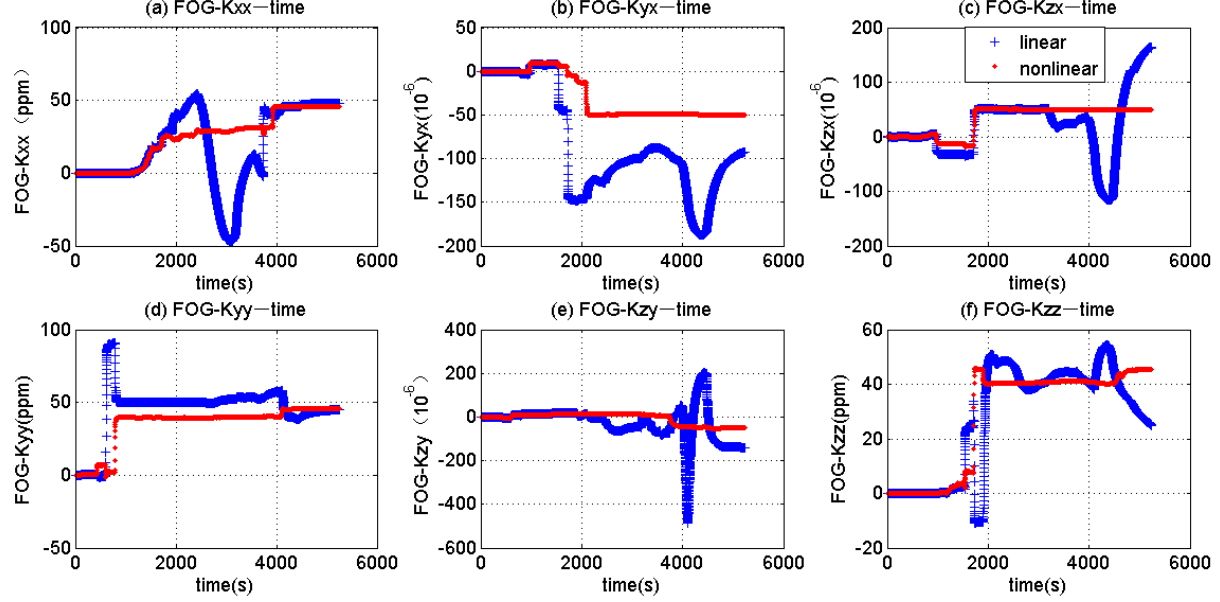
Figure 8. Estimated results of the scale factor error and misalignment error (FOGs).